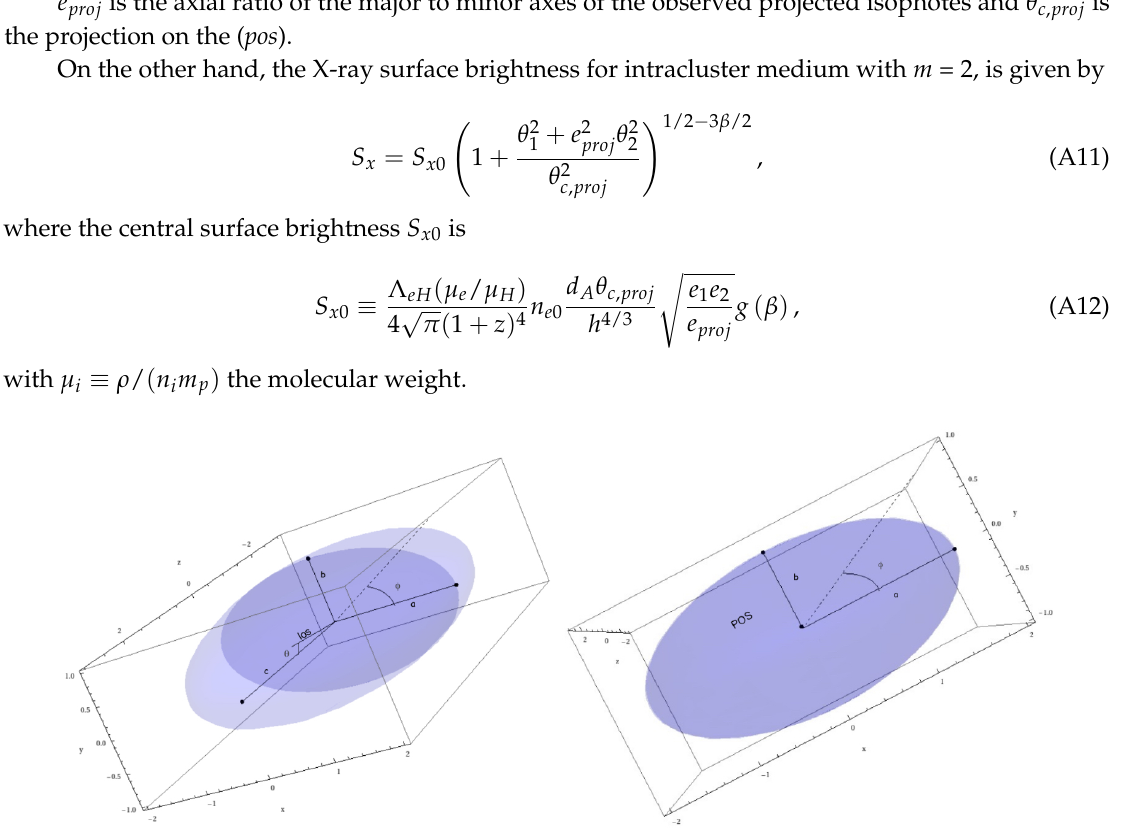
Figure A1. Ellipsoid coefficients a, b and c, with the los making an angle θ with the z-axis (up). View of the pos with the los oriented along the z -axis